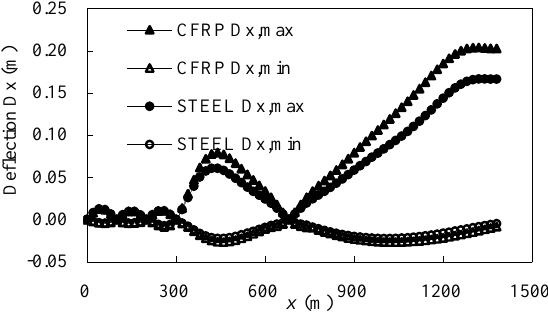
Figure 16. Maximum and minimum girder deflections under live load.